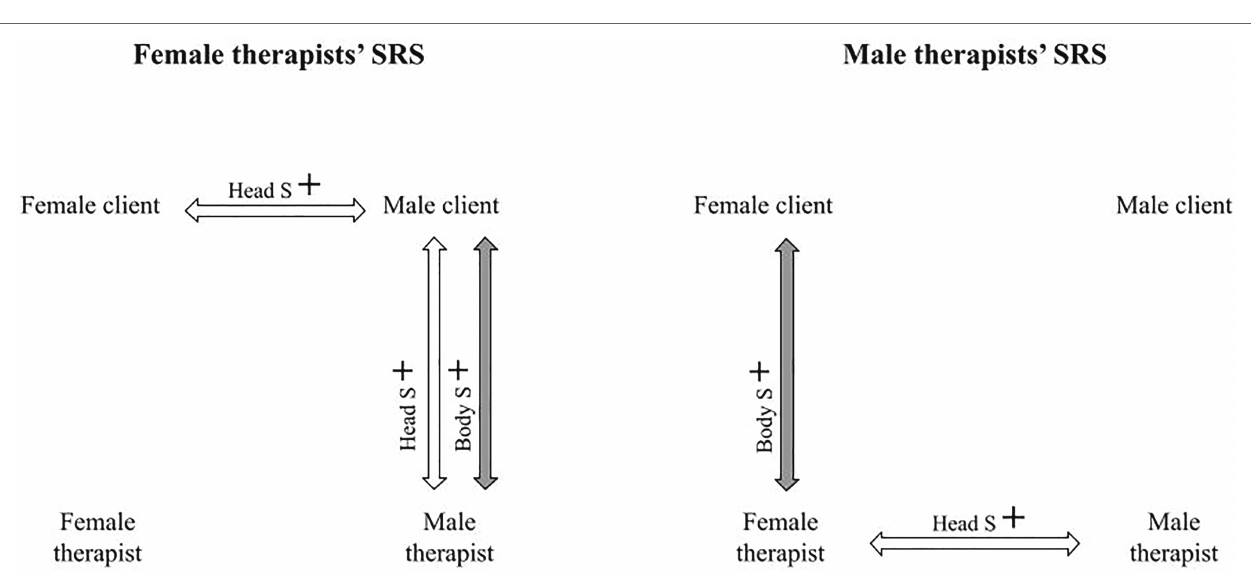
nonverbal synchronies were case wise aggregated,